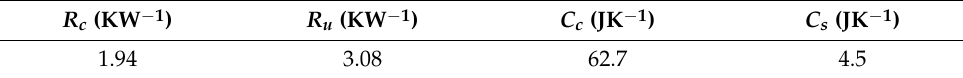
Table 1. The thermal parameters.